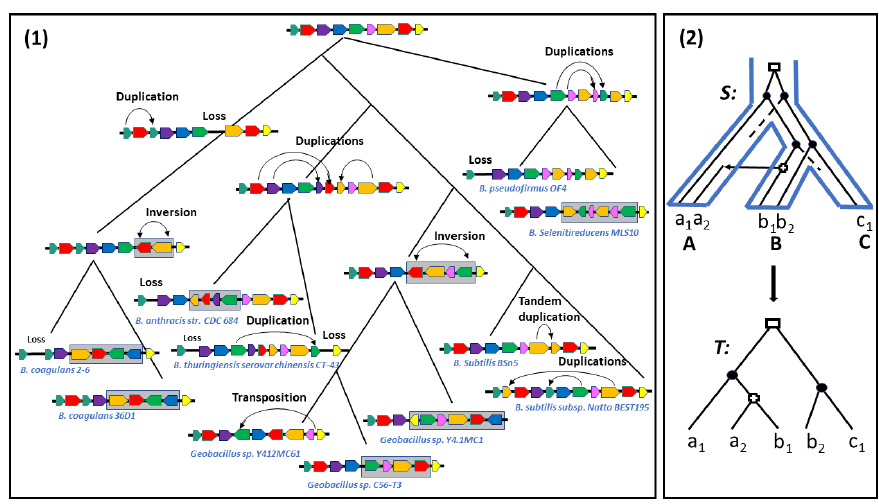
Figure 1. ( 1 ) An evolutionary history of syntenic regions, inspired by Figure 4 in [1], representing the evolution of tRNA repertoires in the Bacillus genus. The tree represents the speciation history of a set of Bacillus species. Each colored arrow represents a block of tRNAs, following the operon subdivision available for B. cereus . Two arrows of the same color represents a duplicated block. Gray rectangles indicate the segment affected by an inversion. Notice that blocks orientation (indicated by the orientation of the arrow) does not reflect the reality, it is just given to illustrate the effect of an inversion, which not only inverts the order, but also the orientation of the blocks. ( 2 ) An evolutionary history of a single-gene family (for example, a set of arrows of one given color in the set of bacterial genomes) belonging to the set of genomes Σ = { A , B , C } . The gene family Γ = { a 1 , a 2 , b 1 , b 2 , c 1 } is such that a gene x i belongs to the genome X . The evolution of the gene family inside the species tree S is represented up, and the induced gene tree T is represented bellow. This evolutionary history involves a duplication (represented by a rectangle), losses (dotted lines) and a HGT event (represented by a horizontal line in S and a cross in T